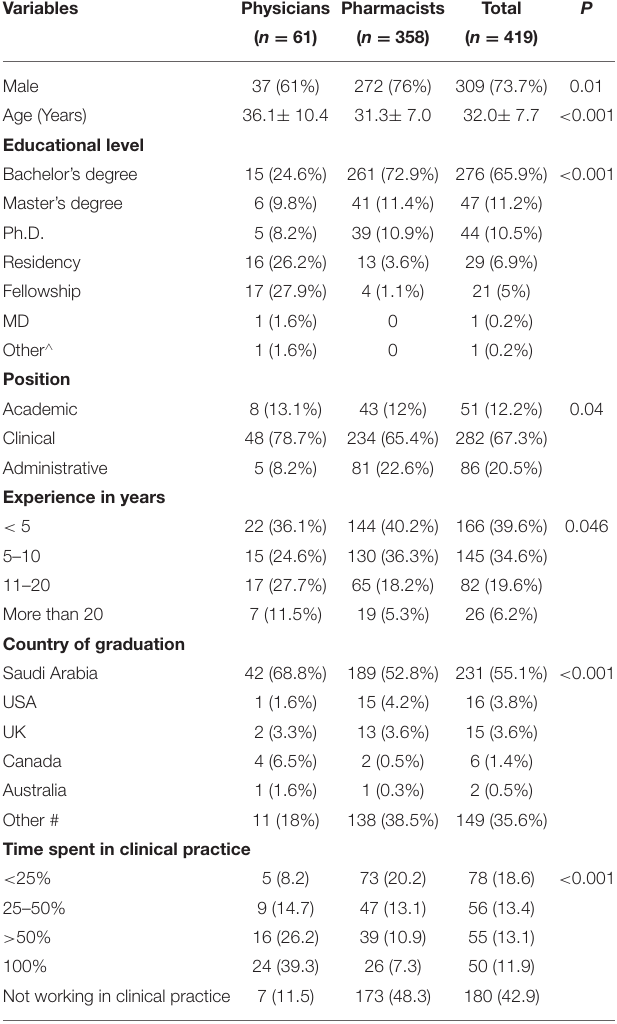
TABLE 1 | Socio-demographic characteristics of the study